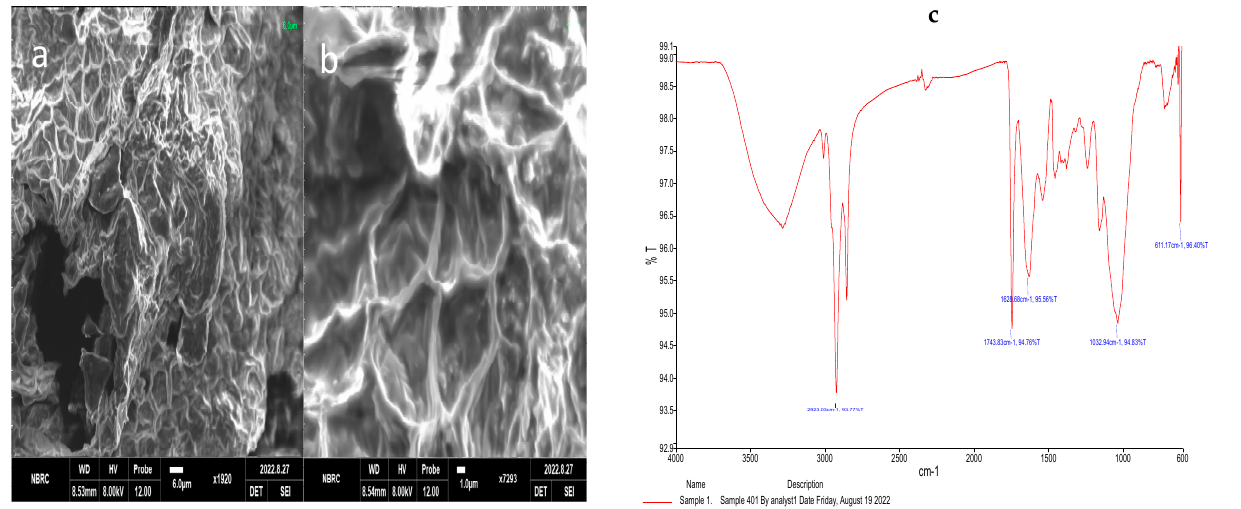
Figure 2. Scanning Electron Micrograph (SEM) images and Fourier transform infrared spectroscopy (FT − IR) of okara flour ( a ) hollow sphere, ( b ) rough structure, and ( c ) spectrum of okara